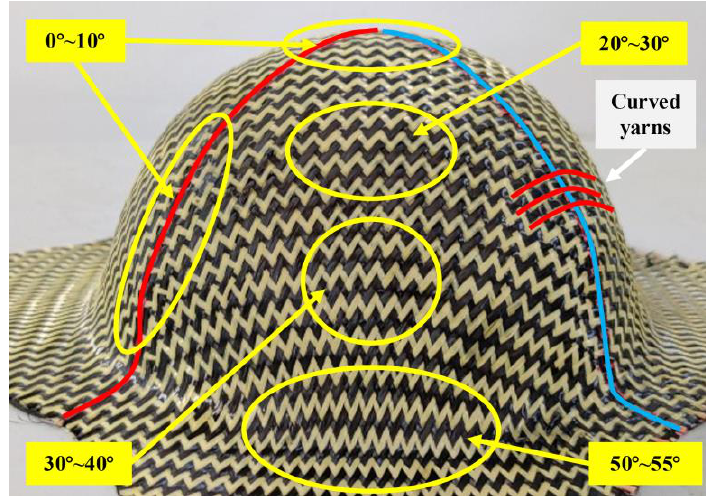
Figure 12. Shear angle distribution after hemispherical preforming. Red lines for weft yarns; blue lines for warp yarns; yellow lines for shear zones.